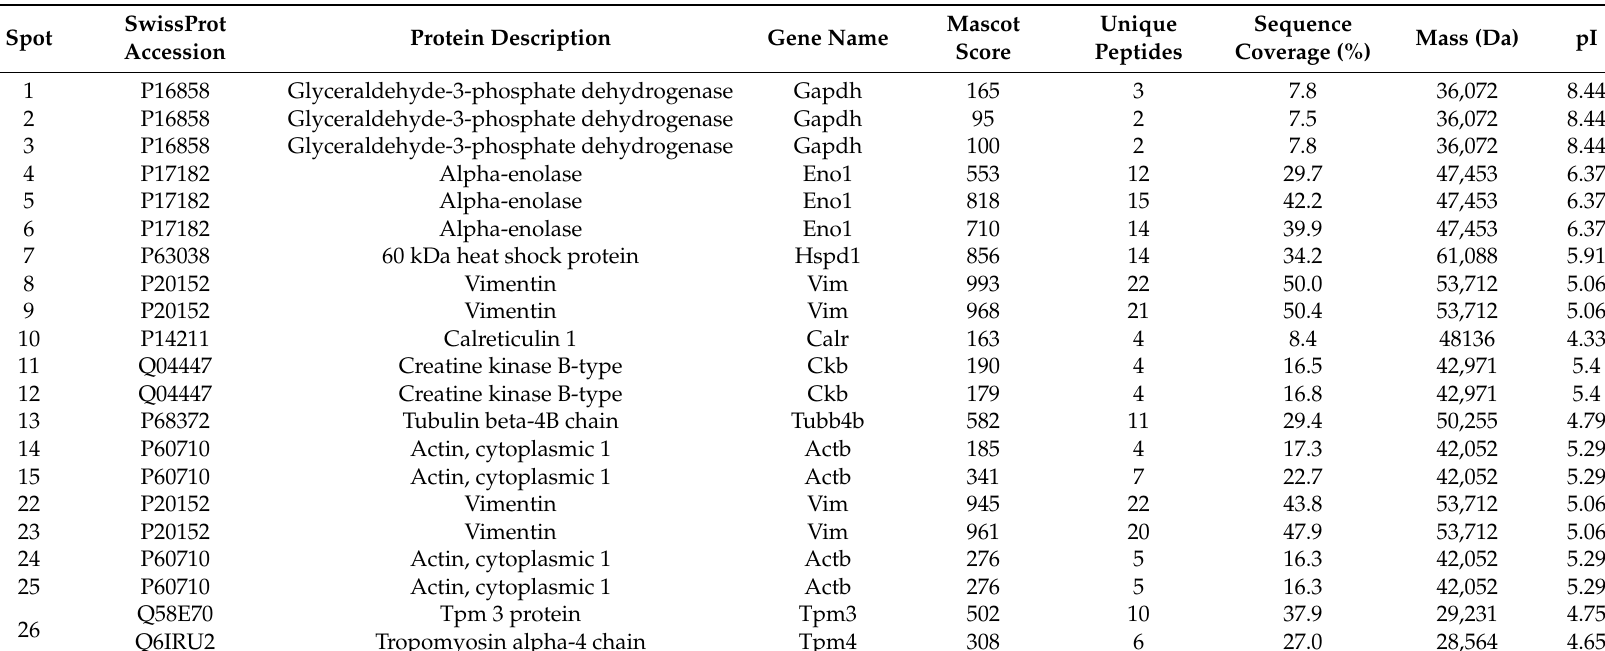
Table 1. Mass spectrometry analysis of tryptic digests from S -glutathionylated proteins. Spot number, SwissProt accession, protein description, gene name, Mascot score, number of unique peptides identified, sequence coverage, and theoretical mass and pI values are